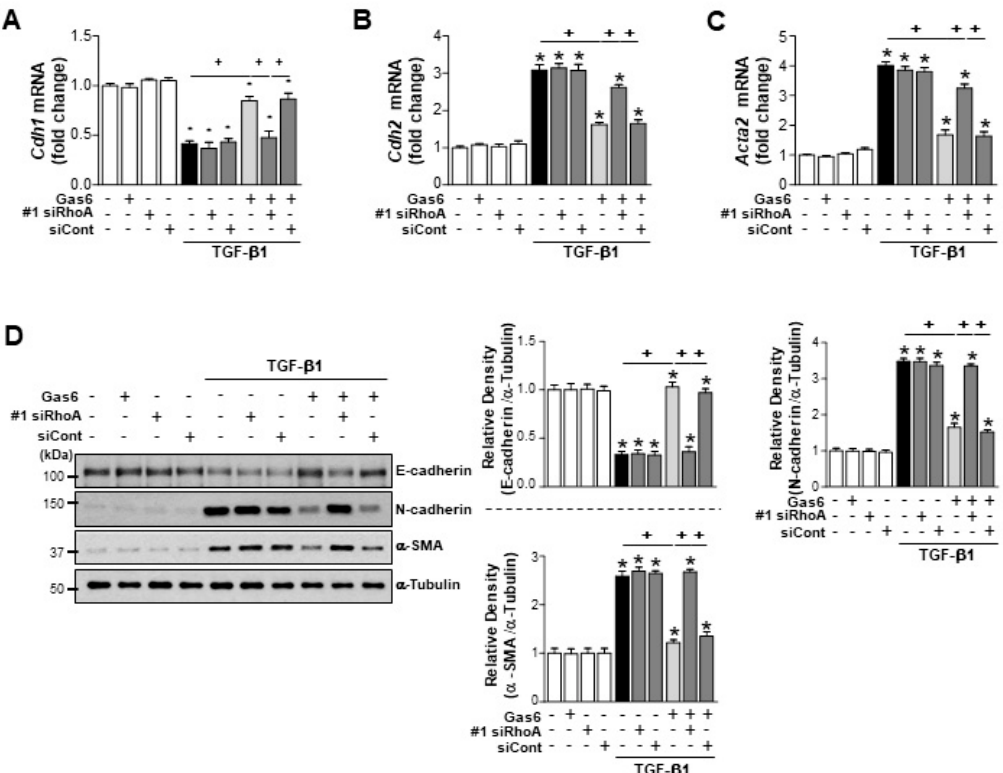
Figure 3. RhoA is involved in the Gas6-induced inhibition of epithelial–mesenchymal transition (EMT) in LA-4 cells. LA-4 cells were transfected with RhoA -specific or control siRNAs (#1 siRhoA or siCont) for 24 h prior to treatment with 400 ng / mL Gas6 for 20 h and then stimulated with 10 ng / mL transforming growth factor (TGF)- β 1 for 48 h. ( A – C ) qPCR analysis of the mRNA levels of EMT markers and EMT-regulating transcription factors. ( D ) Immunoblots of total cell lysates were performed using anti-E-cadherin, anti-N-cadherin, or anti- α -SMA antibodies. Densitometry of the relative abundances of the indicated EMT markers. Alpha-tubulin was used as a control. Values represent the mean ± SEM of three independent experiments. * p < 0.05 compared with control; + p < 0.05, as indicated. Results are representative of three independent experiments.